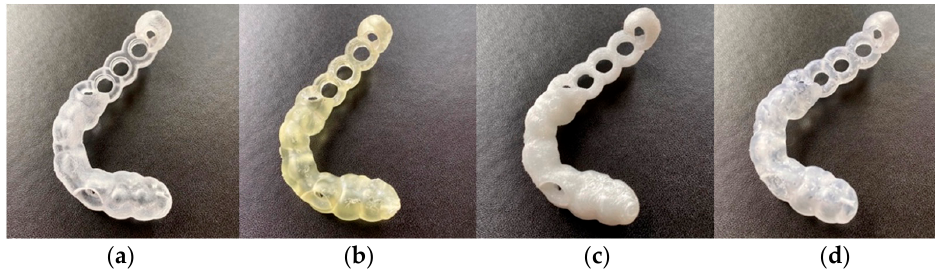
Figure 2. Printed drill guides after removal of support structures: ( a ) Objet30 Prime, ( b )Form 3, ( c ) Ultimaker 3 Extended, ( d ) Duplicator 7 Plus.